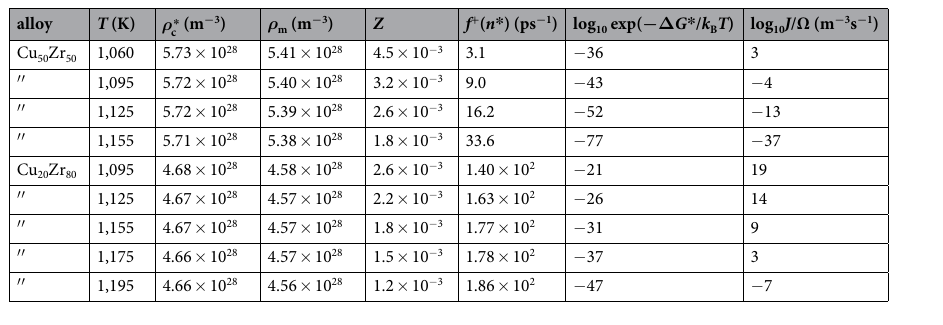
Table 2. Obtained parameters with respect to the nucleation